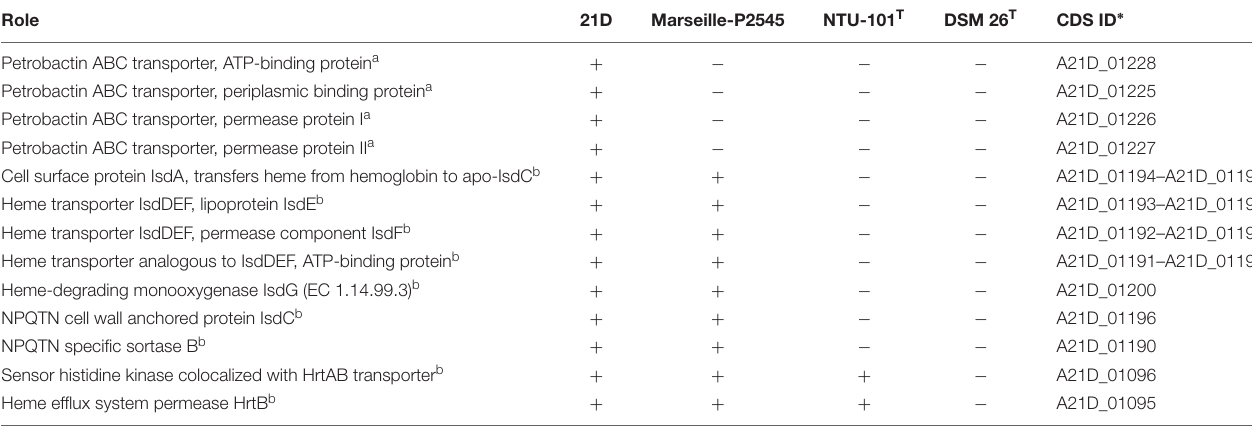
TABLE 7 | Comparison among selected functions in V. dokdonensis 21D, V. dokdonensis Marseille-P2545, V. chiguensis NTU-101 T , and V. pantothenticus DSM 26 T by using automatic RAST function-based comparison tool.